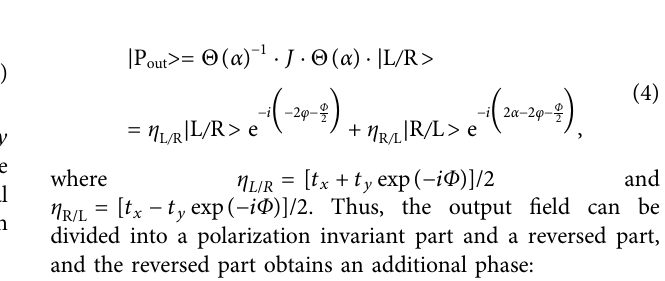
FIGURE 2 | Design process of a vortex beam splitter is decomposed to demonstrate the principle of PB phase integration. (A – C) Superposition of a vortex phase (A) and a linear gradient phase (B) shows a fork-shaped phase (C) . A selected point is highlighted with a red dot to show the superposition of phase values. (D – F) Poincaréspheresdemonstratethepolarizationevolvingroutes(greenlongitudelines)forthedesiredphasechanges(coloredregions)correspondingtothespeci fi cpoint in (A – C) , respectively. It is shown that the phase changes can be achieved by controlling the evolving routes. (G – I) Desired distributions of the optical axes are painted,whichcorrespondtothedeviceswithphasepro fi lesexhibitedinthe fi rstcolumn. (J – L) Polariscopicanalysesareappliedtoverifythedistributionsoflocaloptical axes. Red and green arrows represent the orientation of incident polarization and the analyzer, respectively. (M – O) Experimental intensities obtain by testing the corresponding